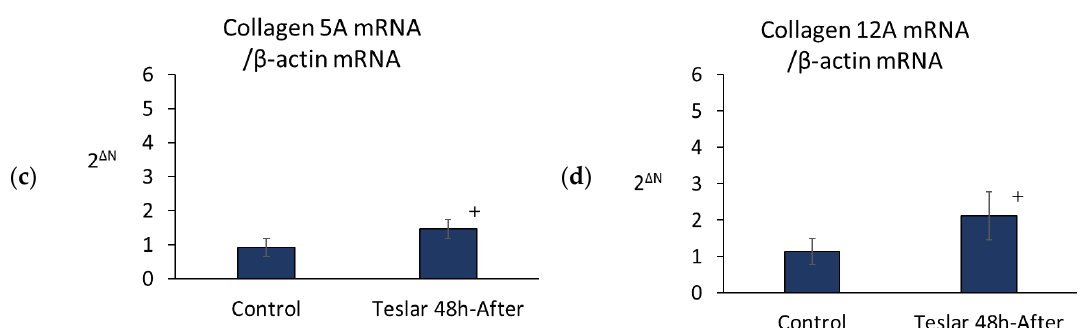
Figure 5. Teslar effect on fibulin-5/DANCE, fibrillin 1, collagen 5A, and collagen 12A mRNA in collagen gel-cultured human fibroblasts. ( a ) fibulin-5/DANCE; ( b ) fibrillin 1; ( c ) collagen 5A and ( d ) collagen 12A. The results are expressed as the mean ± standard deviation of three experiments. * p < 0.05 vs. Control, + p < 0.1 vs. Control.